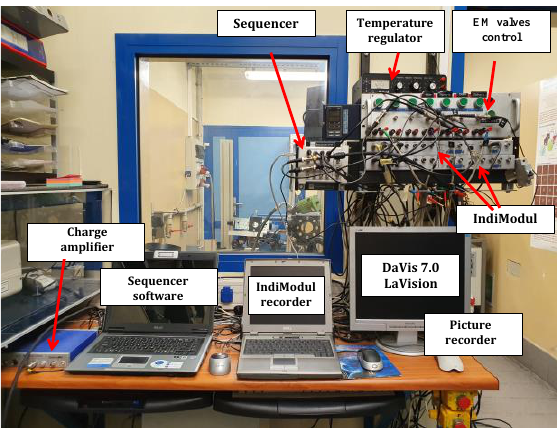
Figure 2. Controlling components of the RCEM, the data acquisition system (sequencer C711, AVL IndiModul 621), the image recording control device (HSS5 LaVision) and the connected measurement channels.